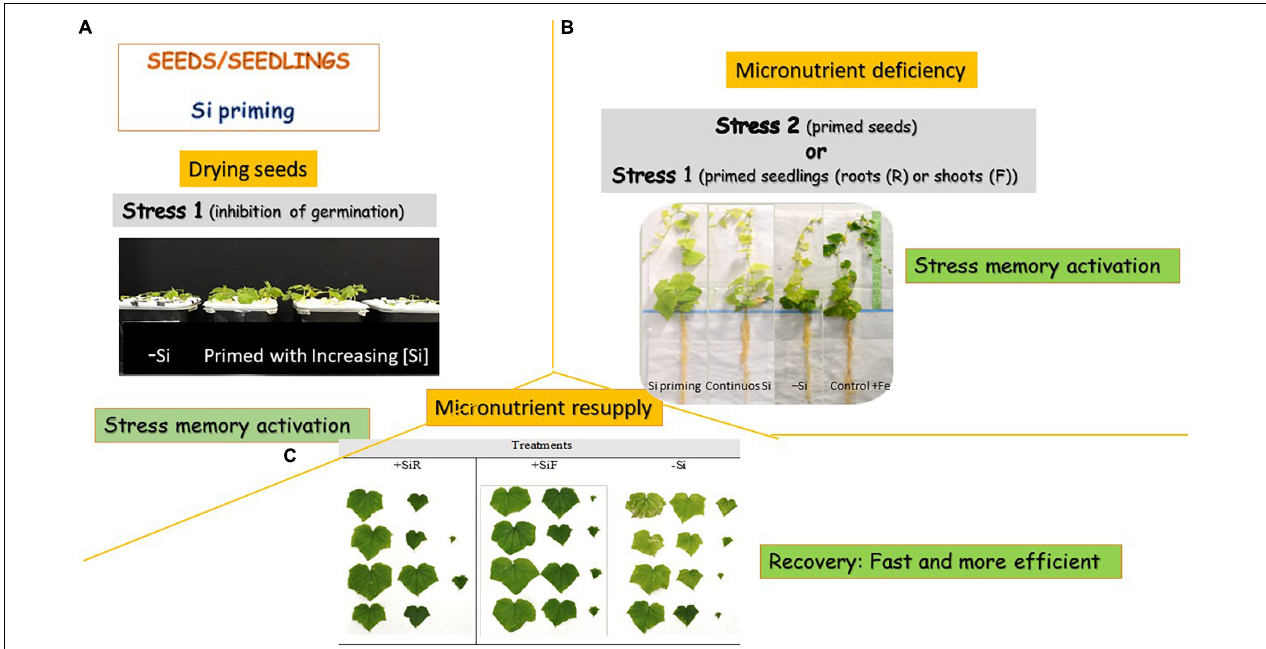
FIGURE 1 | Silicon priming could be done in (A) seeds or seedlings or even in plant parts, and in all cases, stress memory is activated by a stress caused by seeds desiccation. When another stress condition appears, such as a micronutrient deficiency (B) , plant stress memory is activated again, prevent plants from stress symptoms and accelerate plant recovery (C) when stress stops. In this case, the scheme and photos are referred to micronutrient deficiency (Fe) and its resupplying to cucumber